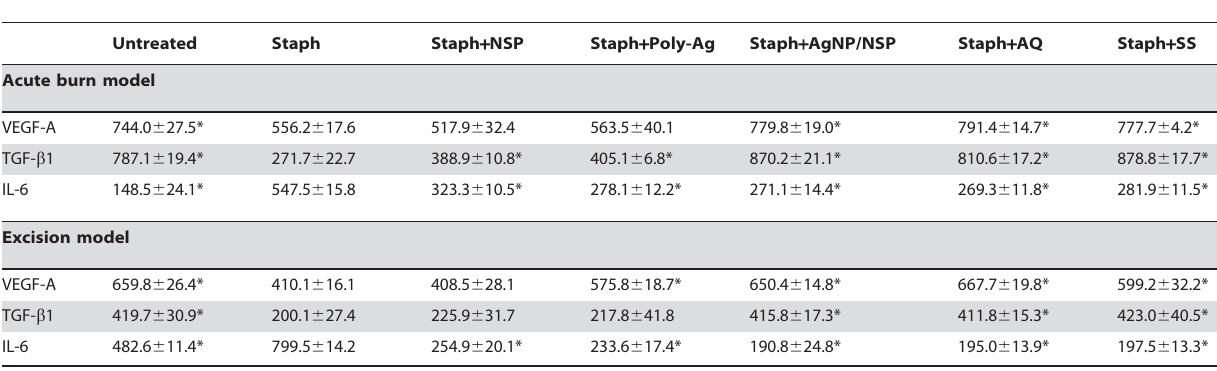
Table 1. Cytokine profile of wound healing.